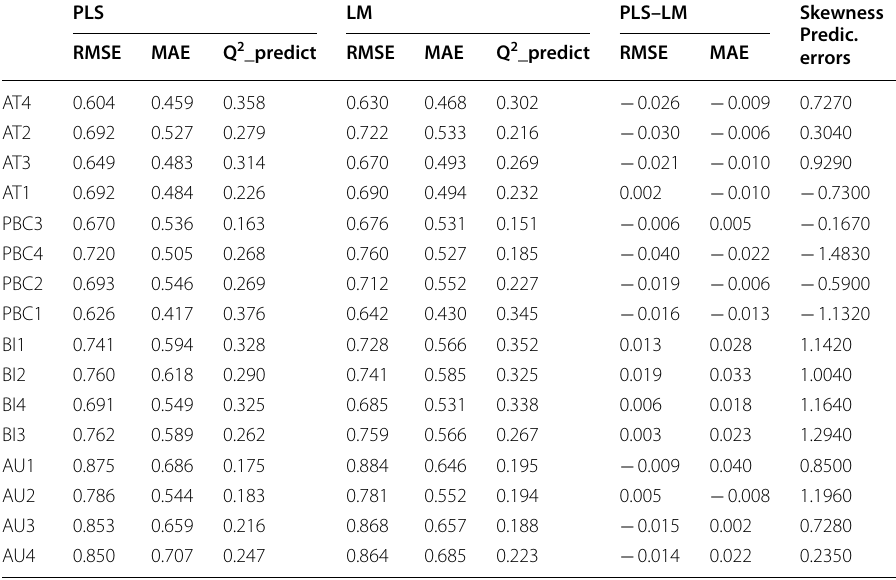
Table 9 PLS assessment of predict